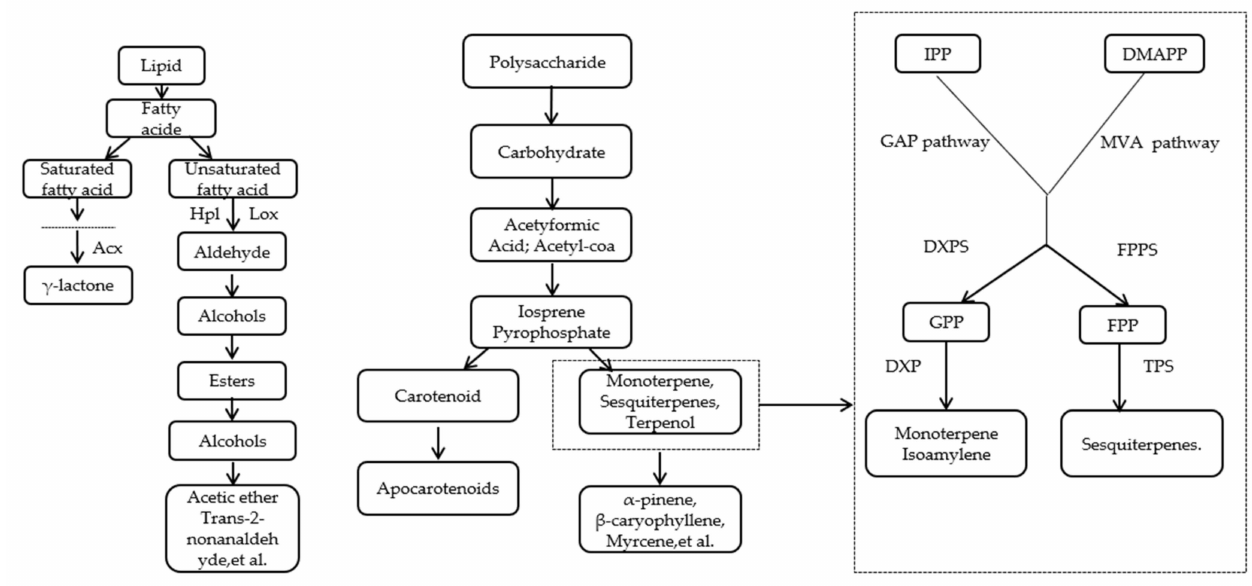
Figure 4. Metabolic pathways and main components of mango aroma